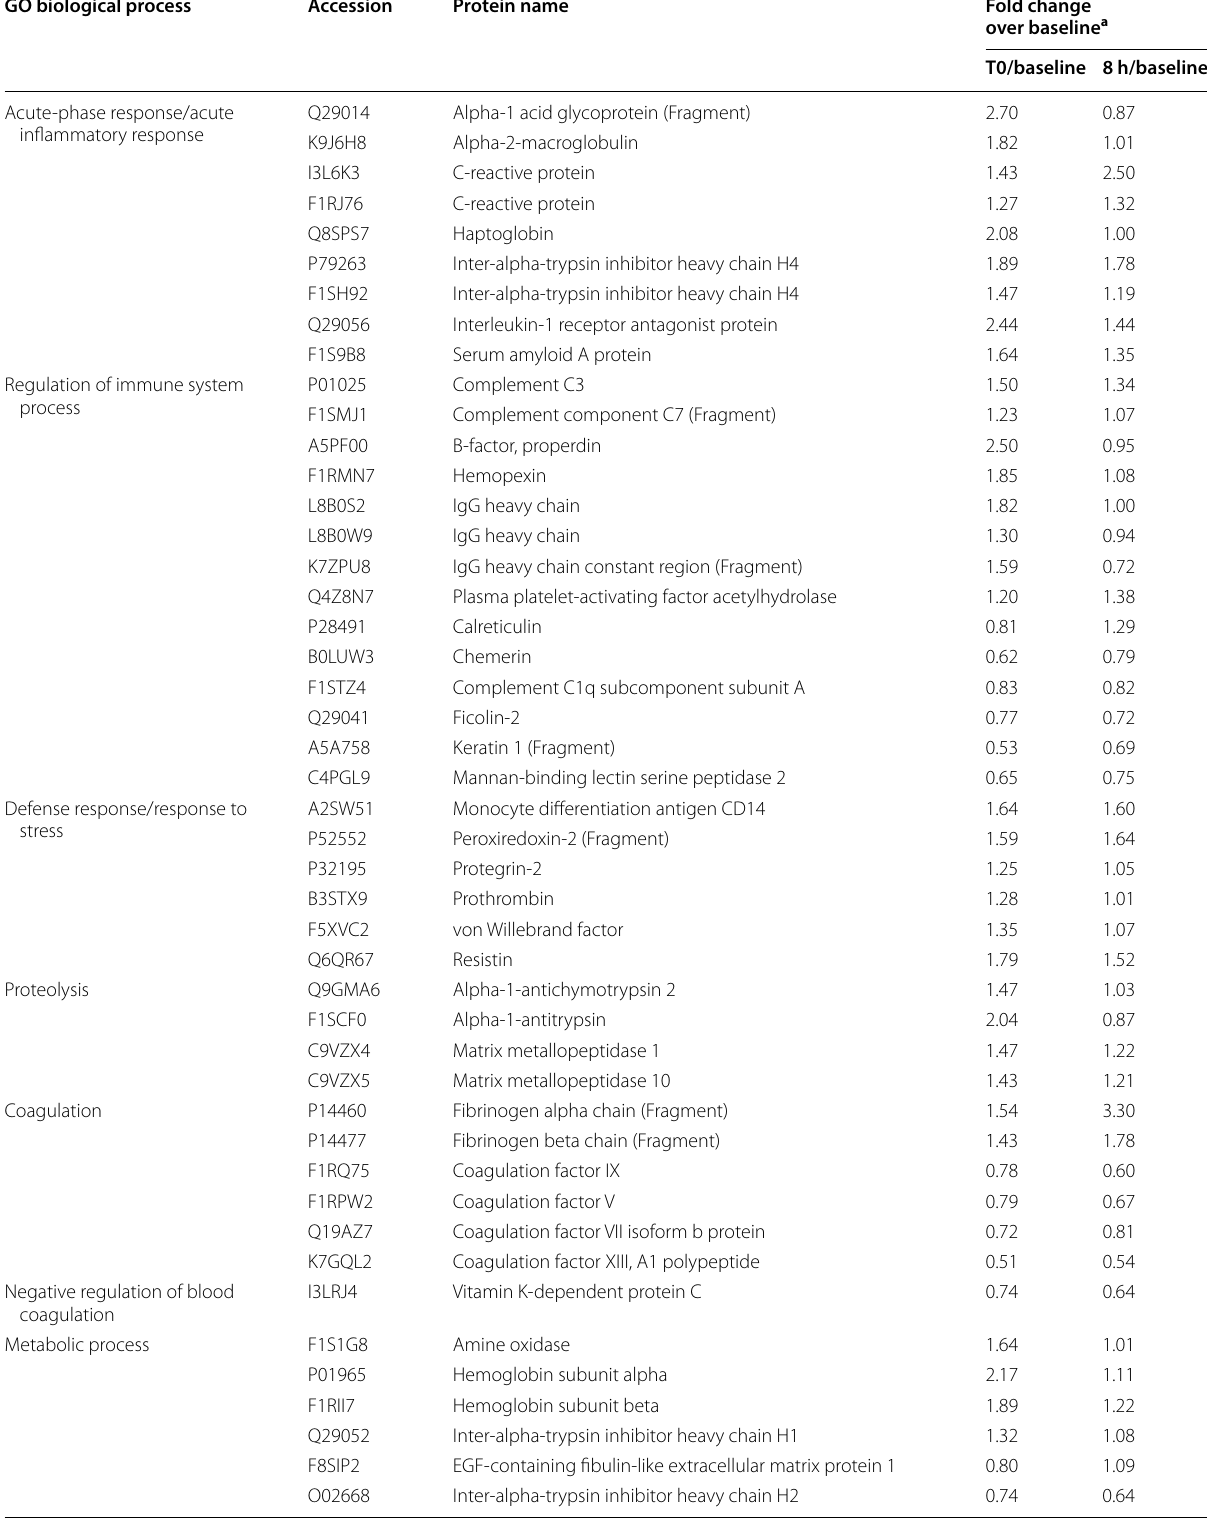
Table 6 Ontology groups and associated differentially expressed plasma proteins in the time points of T0 and 8 h after HA treatment versus